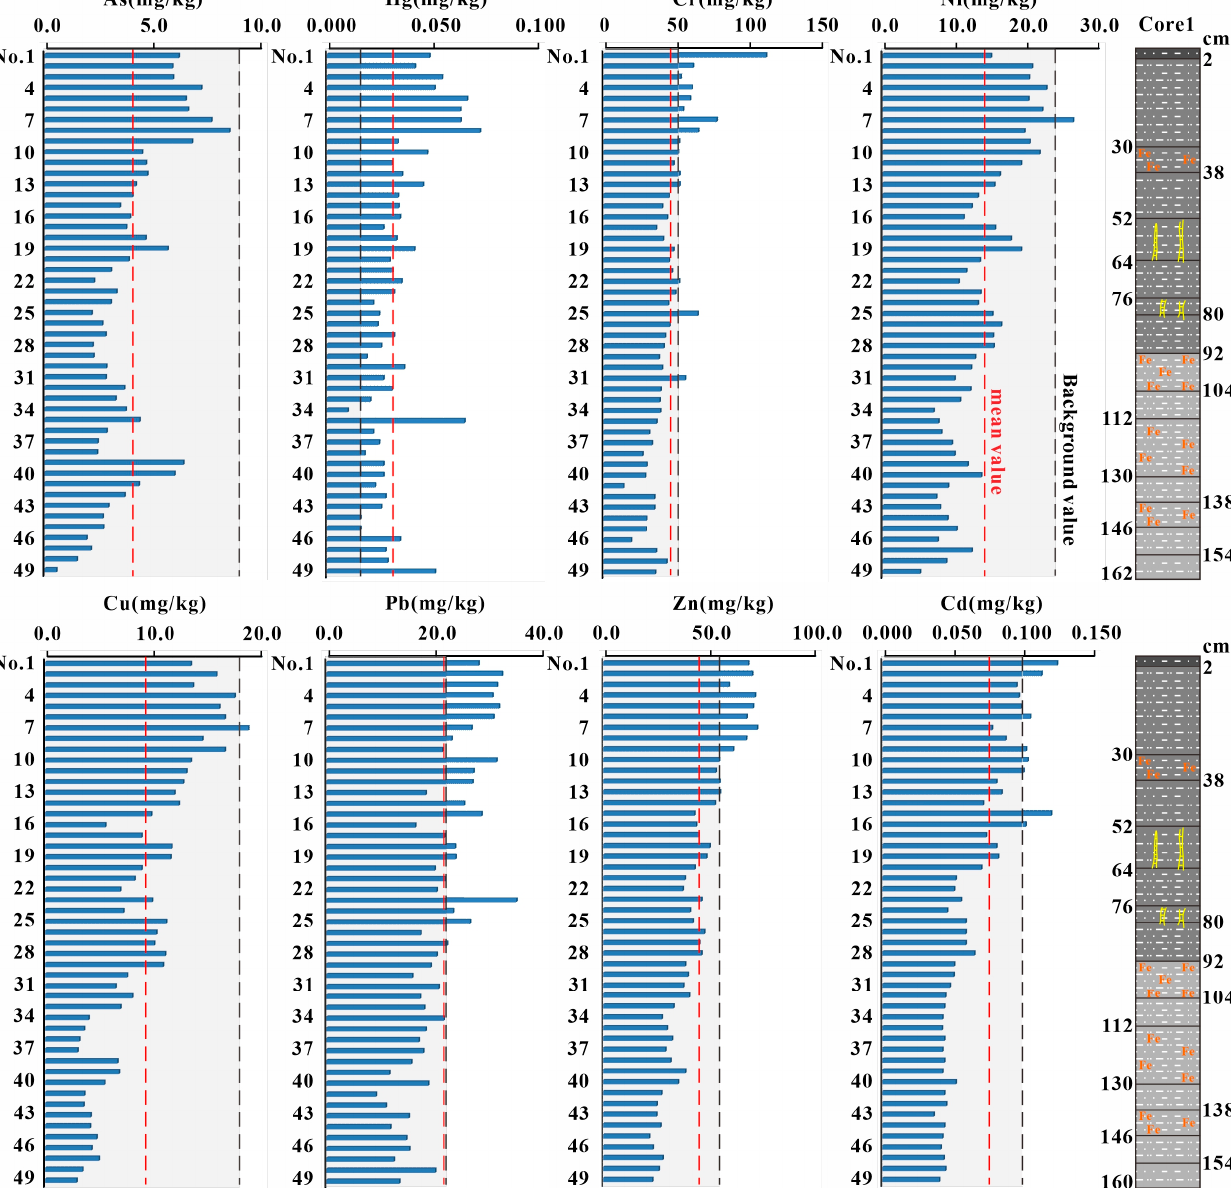
Figure 5. Content profiles of heavy metals in sediment core 1 from Yueliang Lake.